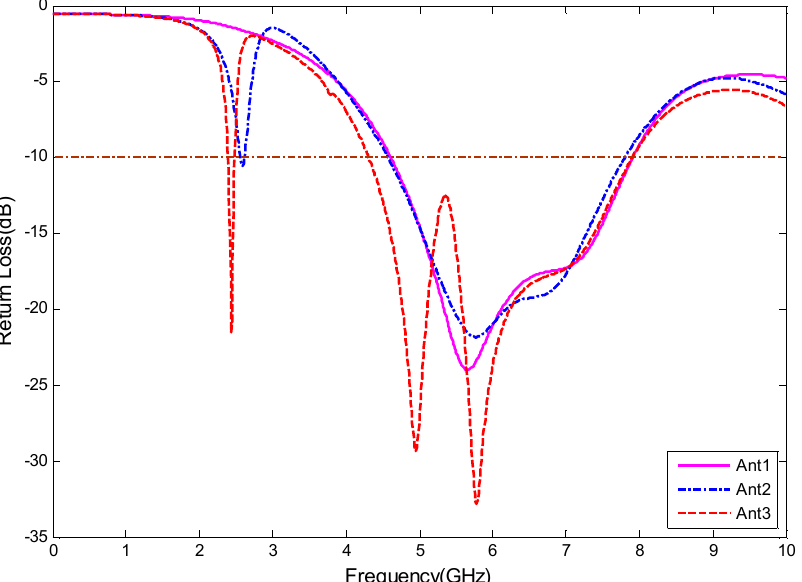
Figure 4. Simulated return loss versus frequency graphs for Antenna 1 (Ant1), Antenna 2 (Ant2), and Antenna 3 (Ant3) (Ant3 being the proposed antenna).